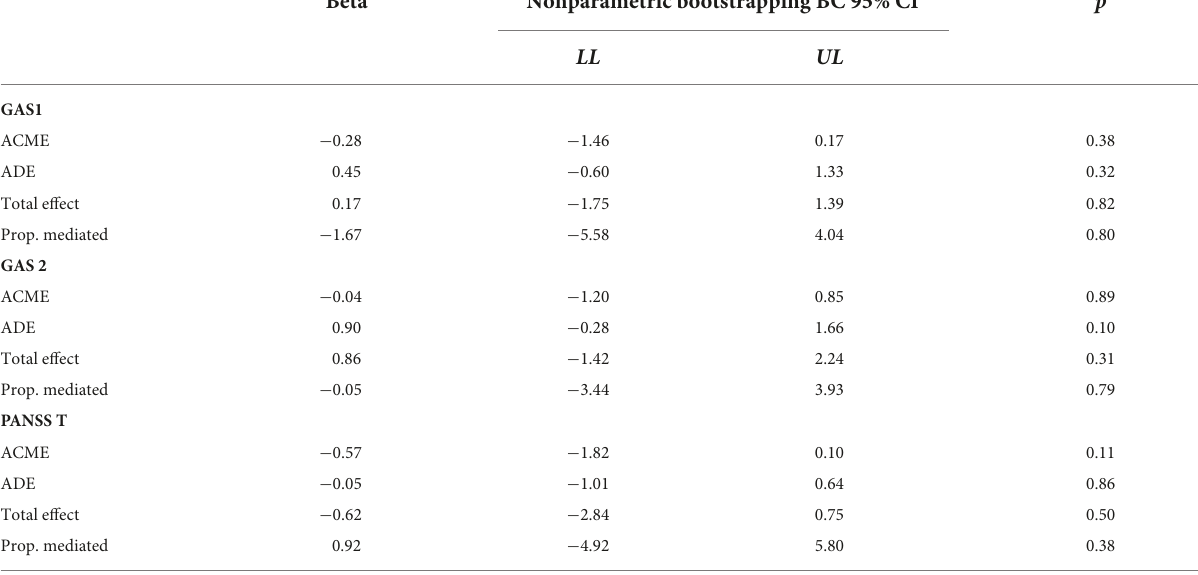
TABLE 3 Non-parametric causal mediation analysis ( n = 27): indirect effect of antipsychotic medication on primary